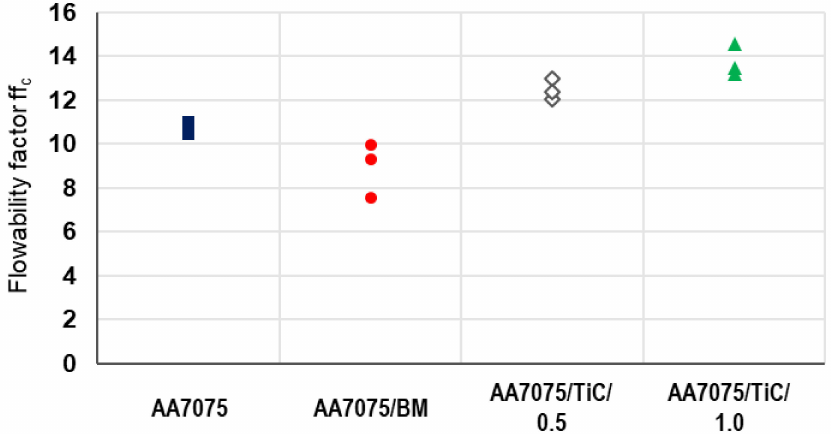
Figure 3. Flowability factor ff c for different powder variants: starting powder AA7075 before and after ball milling (BM), but also mechanically decorated AA7075 powder with TiC NPs (0.5 ma% and 1.0